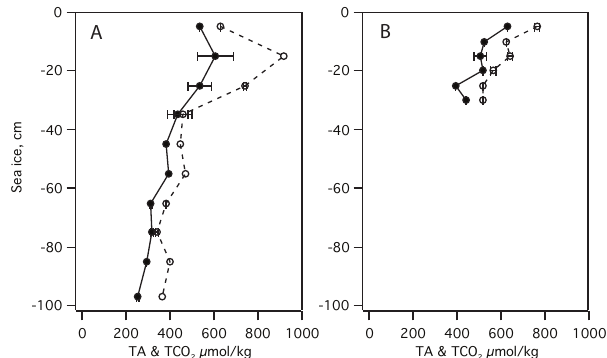
Fig. 8. Vertical profiles of concentration of total alkalinity (- -o- -) and dissolved inorganic carbon (- • -) in (A) at ICE I and (B) at POLY